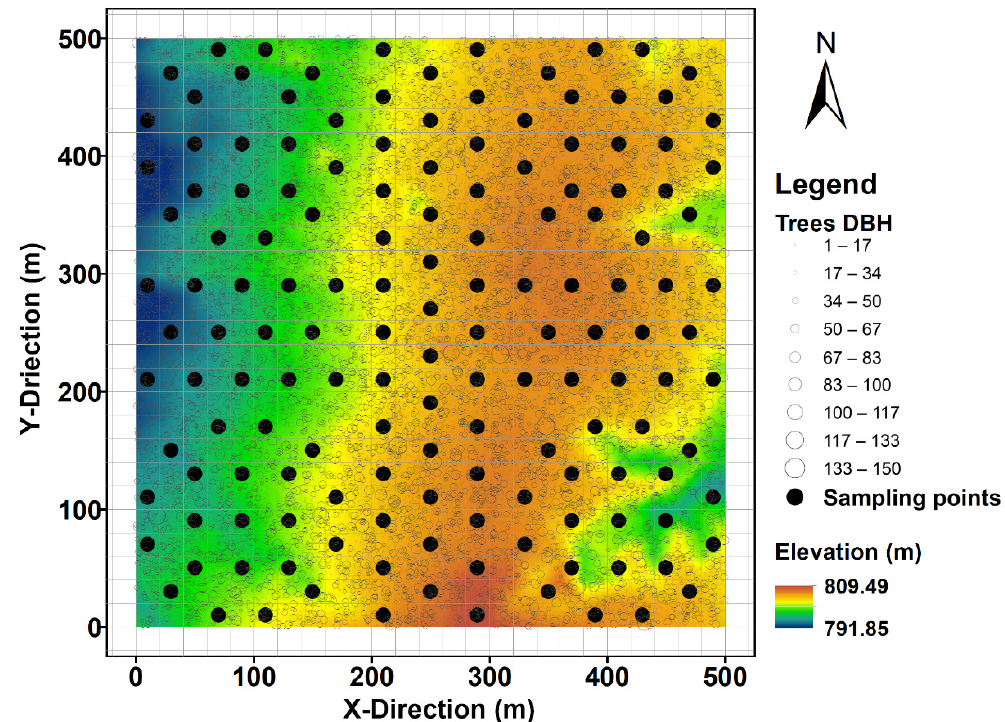
Figure 4. Contour map of the 25 ha Changbaishan Forest Dynamics Plot in Northeast China, showing the sampling points of soil respiration as solid circles and the positions of all living trees as open circles, whereby symbol sizes indicate tree diameter at breast height (DBH). Colours indicate differences in elevation.